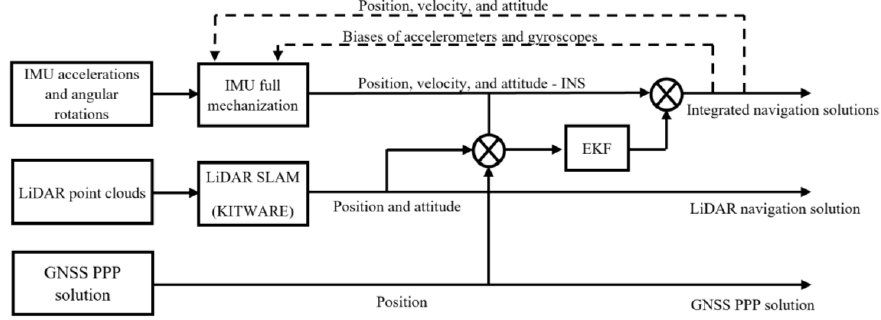
Figure 9. A block diagram for the GNSS/INS/LiDAR SLAM LC integration.